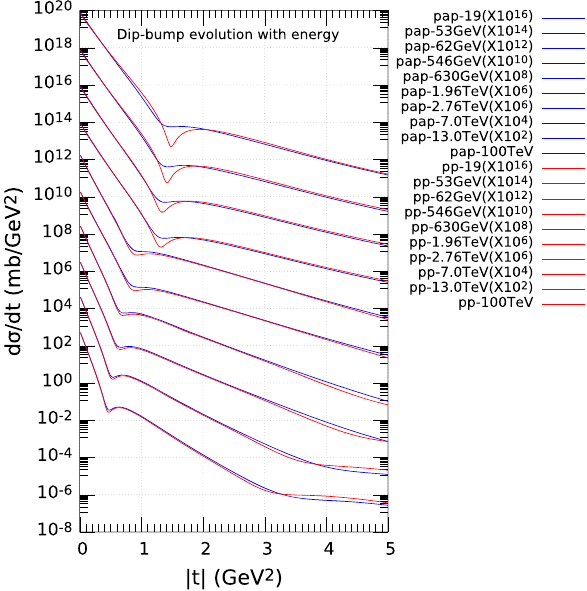
Fig. 9 Evolutionof pp and ¯ pp differentialcrosssectionswithincreas- ing energy